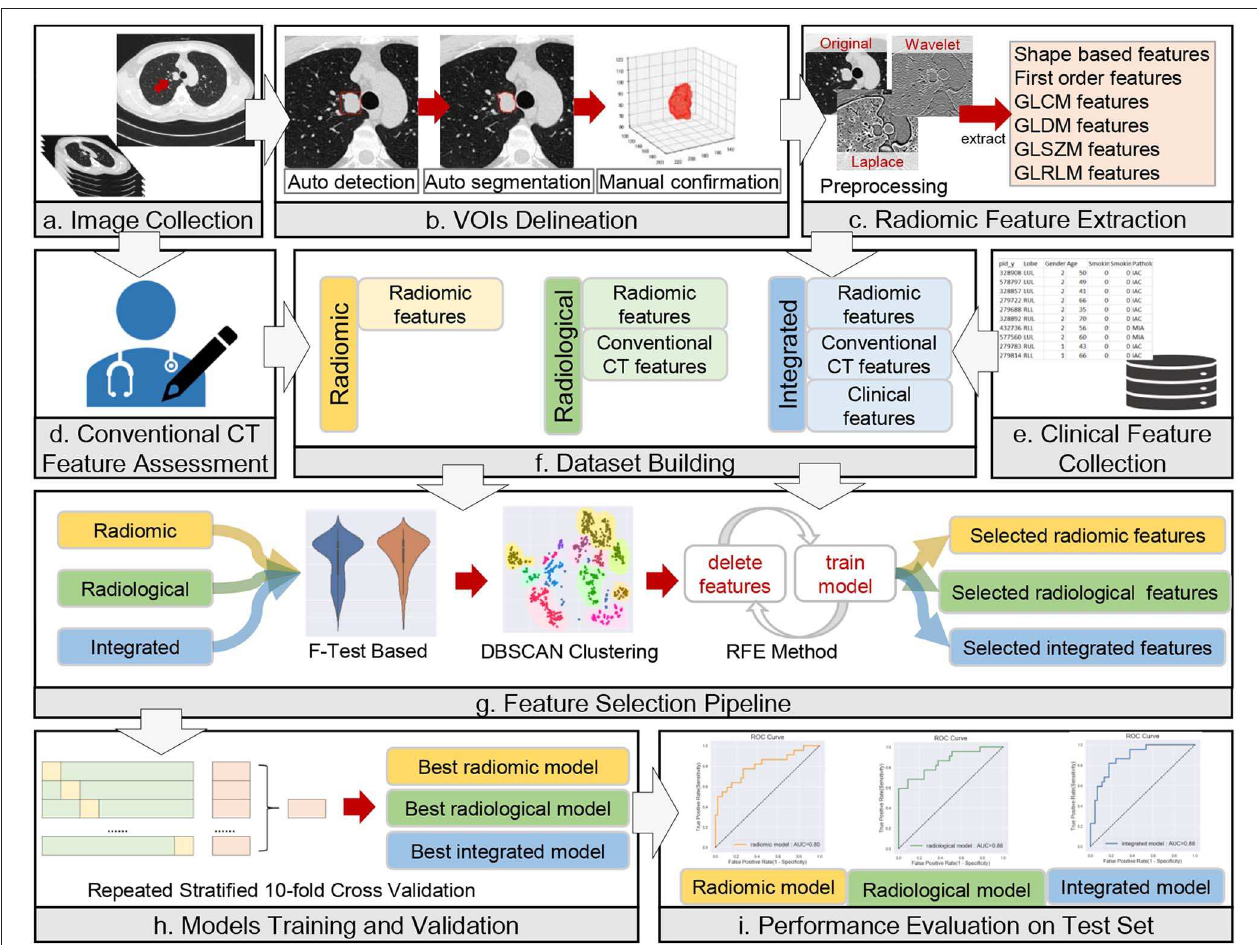
FIGURE 2 | Workflow of data analysis. The workflow illustrates the radiomic, radiological, and integrated modeling and analysis workflow with one example of a CT image and tumor segmentation. (a) A male lung adenocarcinoma patient, 44 years old. (b) Auto-detection, segmentation, and manual confirmation of the targeted lesion. The red square in the first image mimics the detection process. The initial regions of interest (ROIs) are generated in this step. (c–e) Description of the process of collection of radiomic, conventional CT and clinical features. (f–i) Illustrations of dataset building, feature selection, model training and validation, and model evaluation,